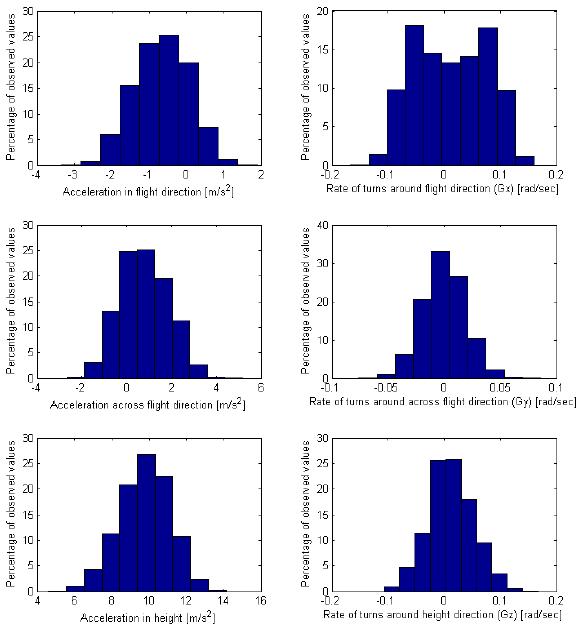
Figure 4. Comparison of FFT results for acceleration in flight direction (uppermost: left strut, middle: right strut and lowermost: inside the passenger area)